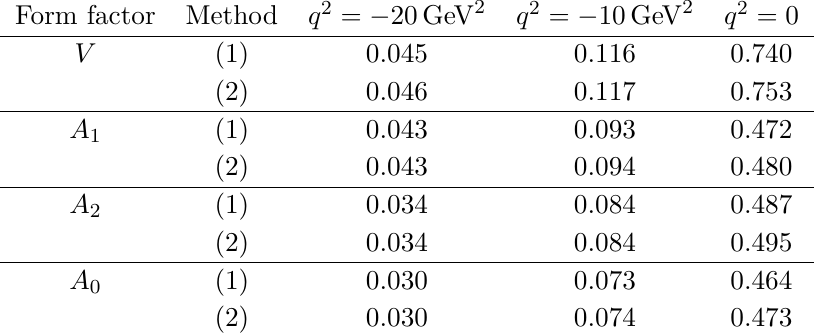
Table 2 . Numerical results for the B c → J/ψ form factors obtained from: (1) the Borel sum rules at M 2 = 3 . 0 GeV 2 and (2) the power moment sum rules with n = 3 at P 2 = 4 m 2 parameters are taken at central